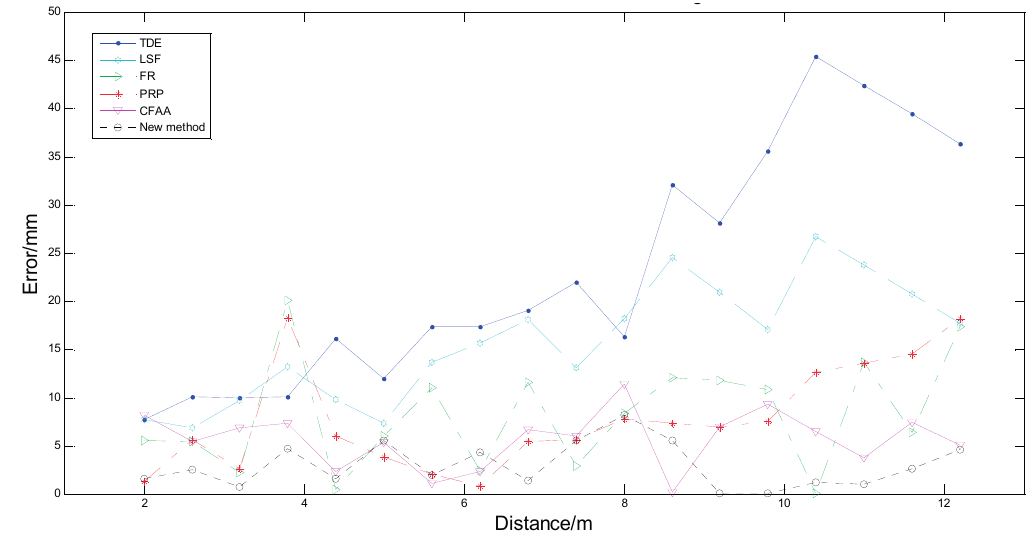
Figure 11. The changes in the relationship between the distance and the estimation